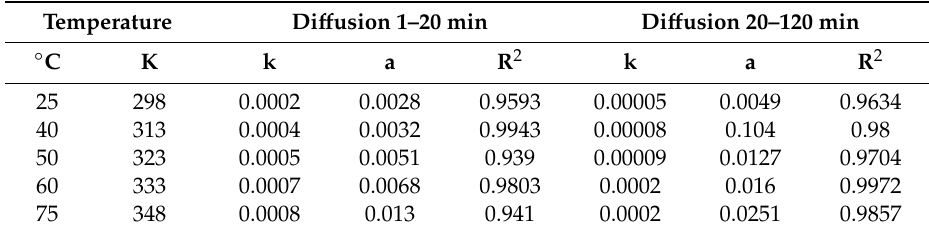
Table 4. Correlation coe ffi cients of di ff usion-controlled kinetics models at di ff erent temperatures for heavy